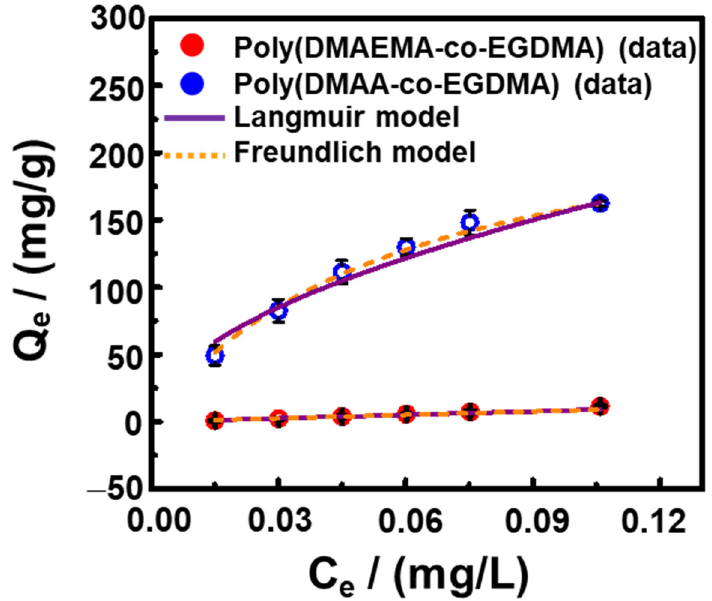
Figure 5. Nonlinear and linear adsorption isotherm curves for poly(DMAEMA ‐ co ‐ EGDMA) and (DMAA ‐ co ‐ EGDMA) films. Experimental data were obtained from the conversion of the resonant frequency change ( Δ f ) in 10–70 ‐ ppm HCl gas flow, at 22 °C and 10% RH.